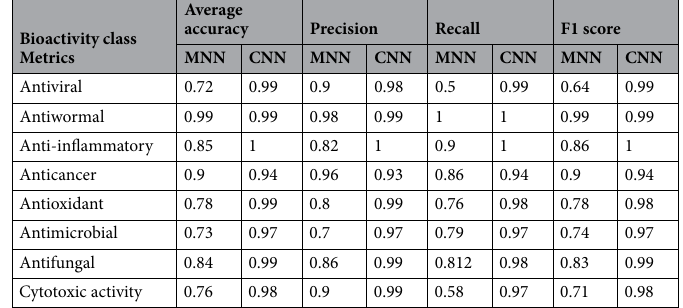
Table 2. The accuracy and relevance metrics for MNN and CNN algorithms in testing stage.